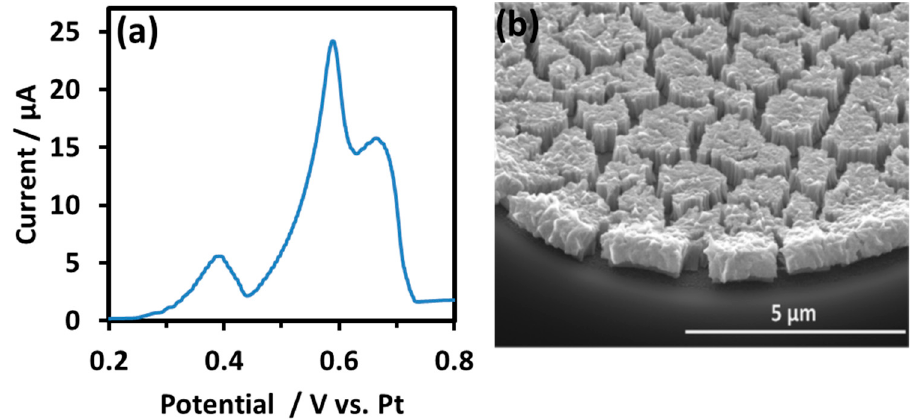
Figure 6. ( a ) LSV of 4 mg/mL salbutamol (as sulphate) in 0.0154 M NaCl and 0.05 mM H 2 SO 4 solution at pH 4 recorded from 0.20 to 0.80 V vs. Pt at 10 mV s − 1 at NPG-modified microdisc array; ( b ) tilted view of NPG-modified microdisc following 10 s deposition of Au 0.18 Ag 0.82 and 6 min etching in 25% nitric acid.